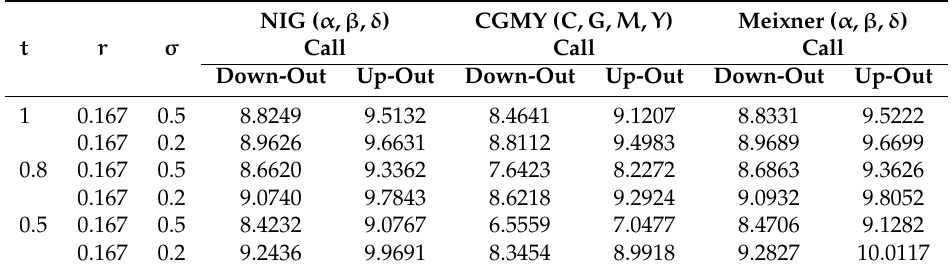
Table 2. Change in Call Price with different types of Lévy Process.